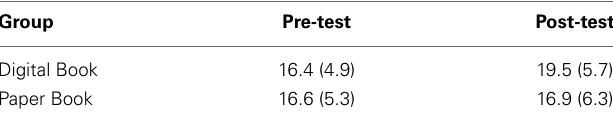
Table 1 | Mean number of characters the participant children correctly answered (SDs) before (Pre-test) and after (Post-test) the exposure to the picture